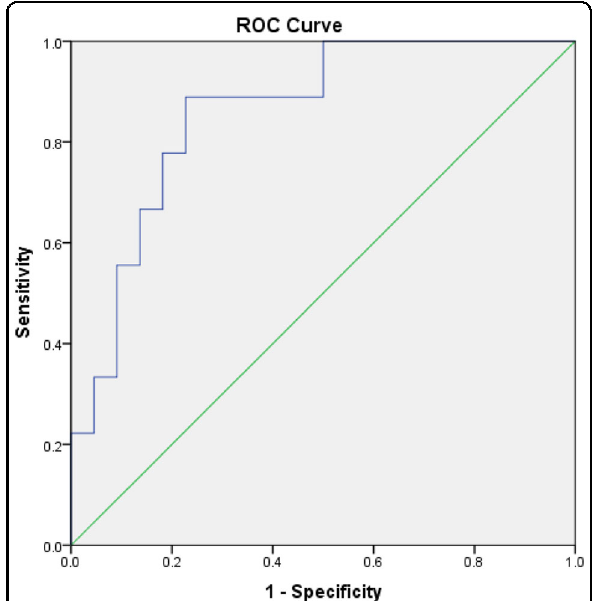
Fig. 1 Receiver operating characteristic (ROC) curve for right UF FA in BD development. Area under the ROC curve = 0.859 (95% CI 0.723 –